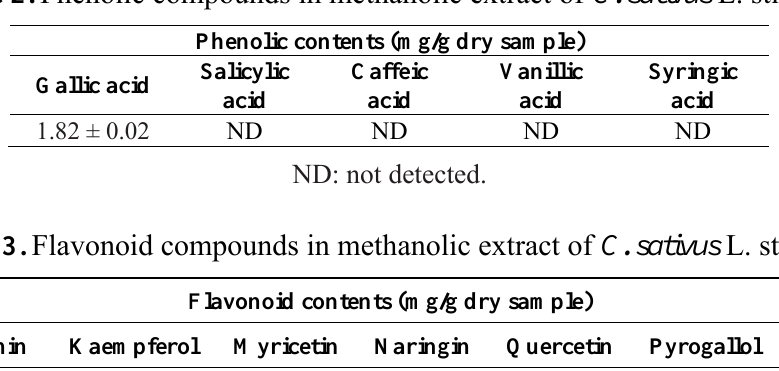
Table 2. Phenolic compounds in methanolic extract of C. sativus L. stigmas.